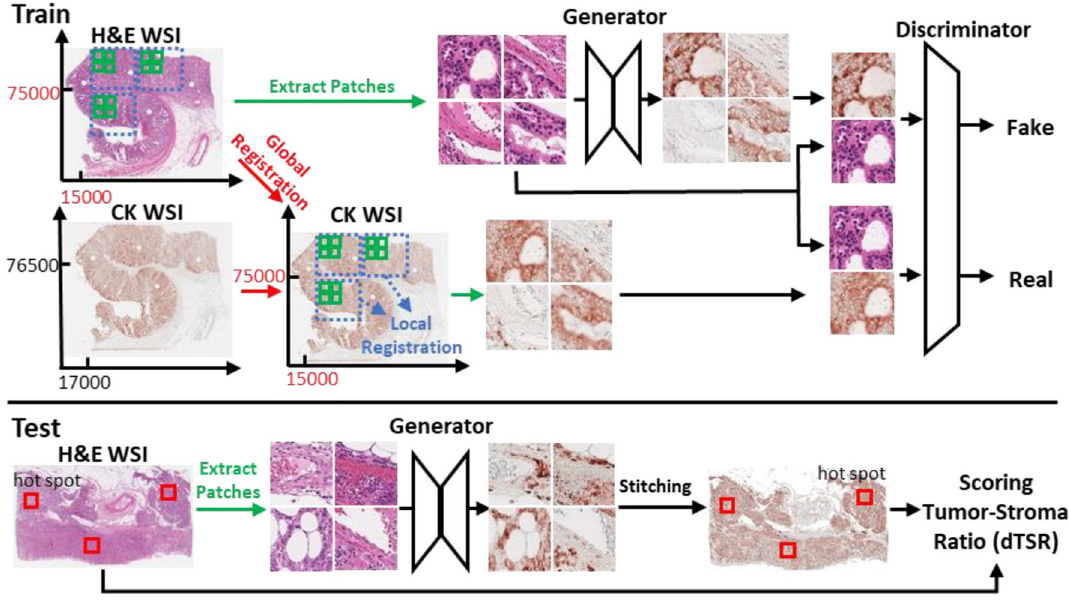
Figure 1. The pipeline of our proposed